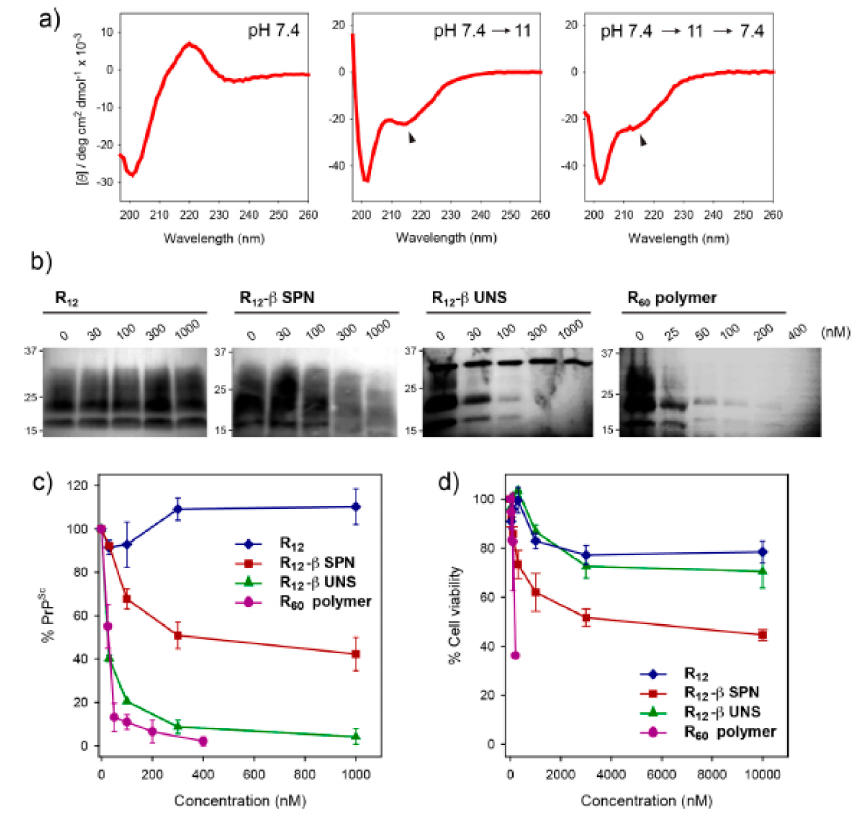
Figure 4. Improvement of anti-prion activity and cytotoxicity with reverse self-assembly of peptide blocks. ( a ) In vitro simulation of self-assembly of R 12 -FKFEFKFEFKFE peptides as pH changes. ( b ) Western blots of prions of which level decreased by reverse self-assembly of R 12 -FKFEFKFEFKFE peptides (R 12 - β UNS). ( c ) Quantitative presentation of anti-prion activity of forward and reverse self-assembled R 12 -FKFEFKFEFKFE peptides. ( d ) Cytotoxicity of forward and reverse